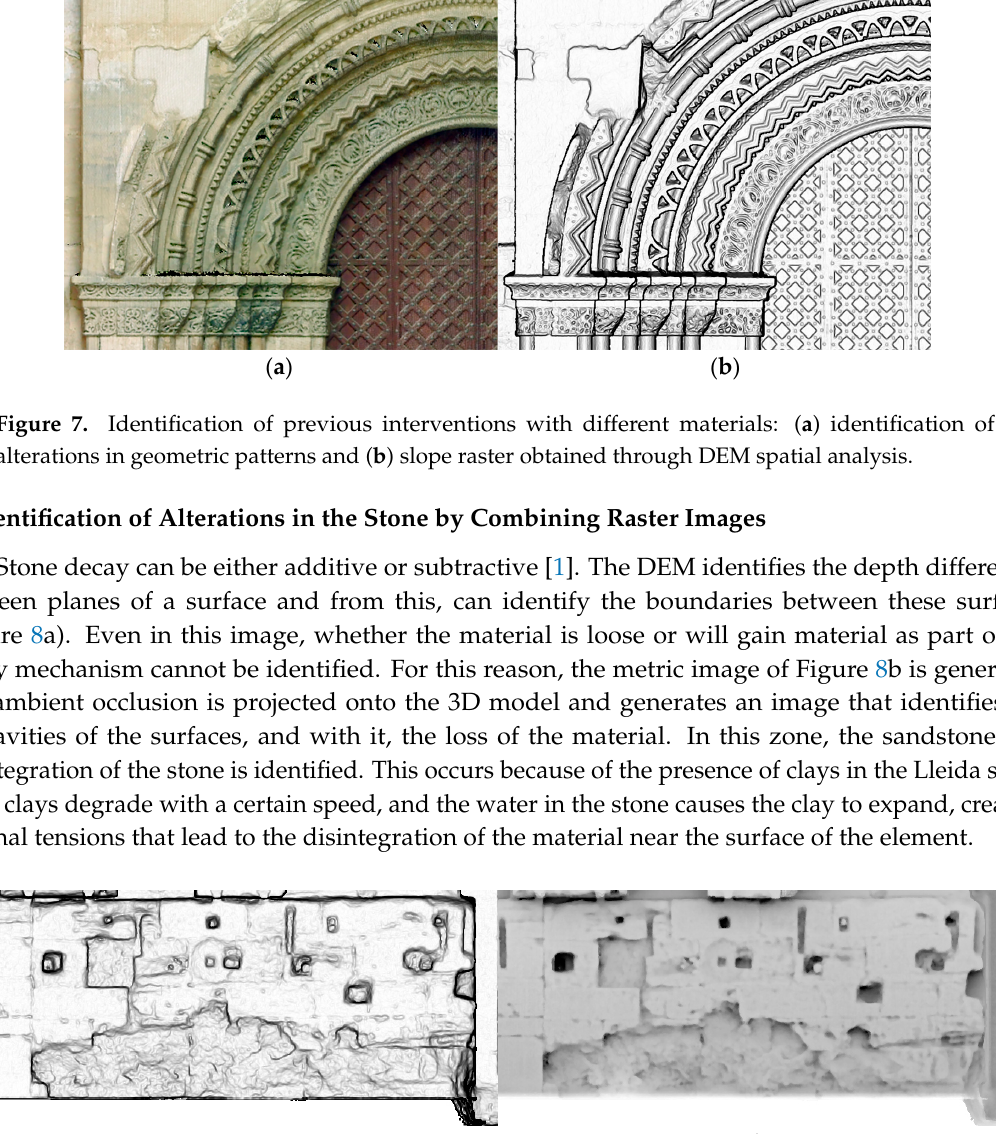
Figure 8. Deterioration of the stone: ( a ) the boundaries between surfaces, the slope, is identified; and ( b ) the sandstone is identified as well as the disintegration of the stone (ambient occlusion).